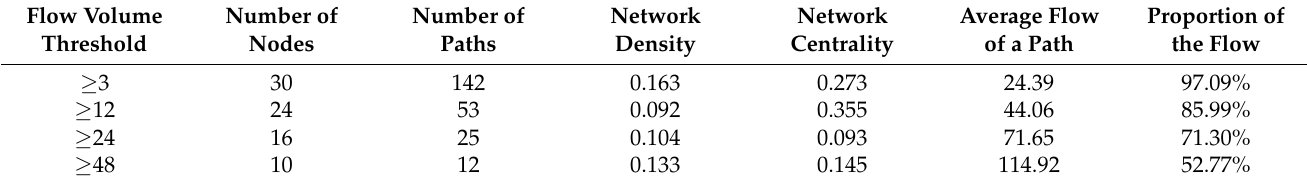
Table 3. Network characteristics under different flow volumes.